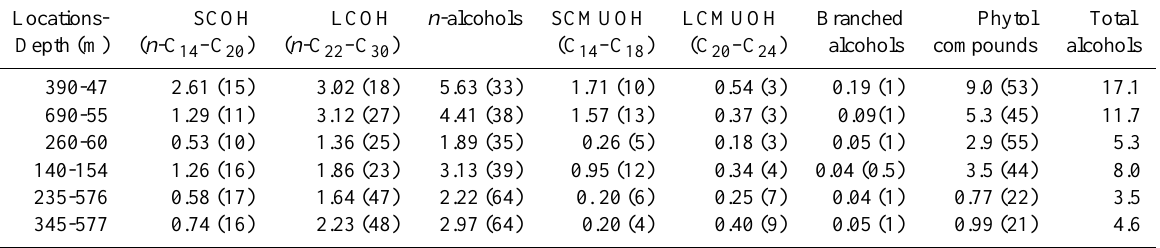
Table 6. Alcohol concentrations in the sediments from the Beaufort Sea (µgg − 1 ). Percentage of total alcohols is given in brackets. Locations- SCOH LCOH n -alcohols SCMUOH